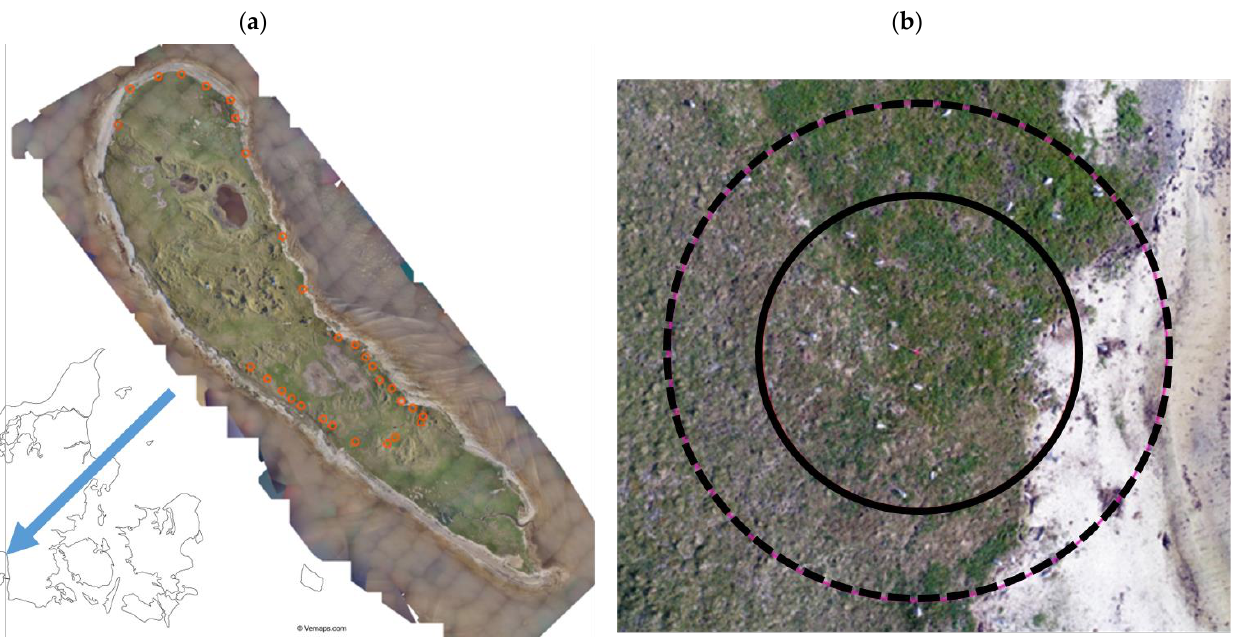
Figure 1. ( a ) Location of the 30 circle plots (in orange) on the island Langli. Image taken with the E384 fixed-wing UAV (TEH). ( b ) Circle plot number 21. The pink line shows the 11 m radius, whereas the red line shows the 7 m radius. Image taken with a DJI Phantom 4 Pro.